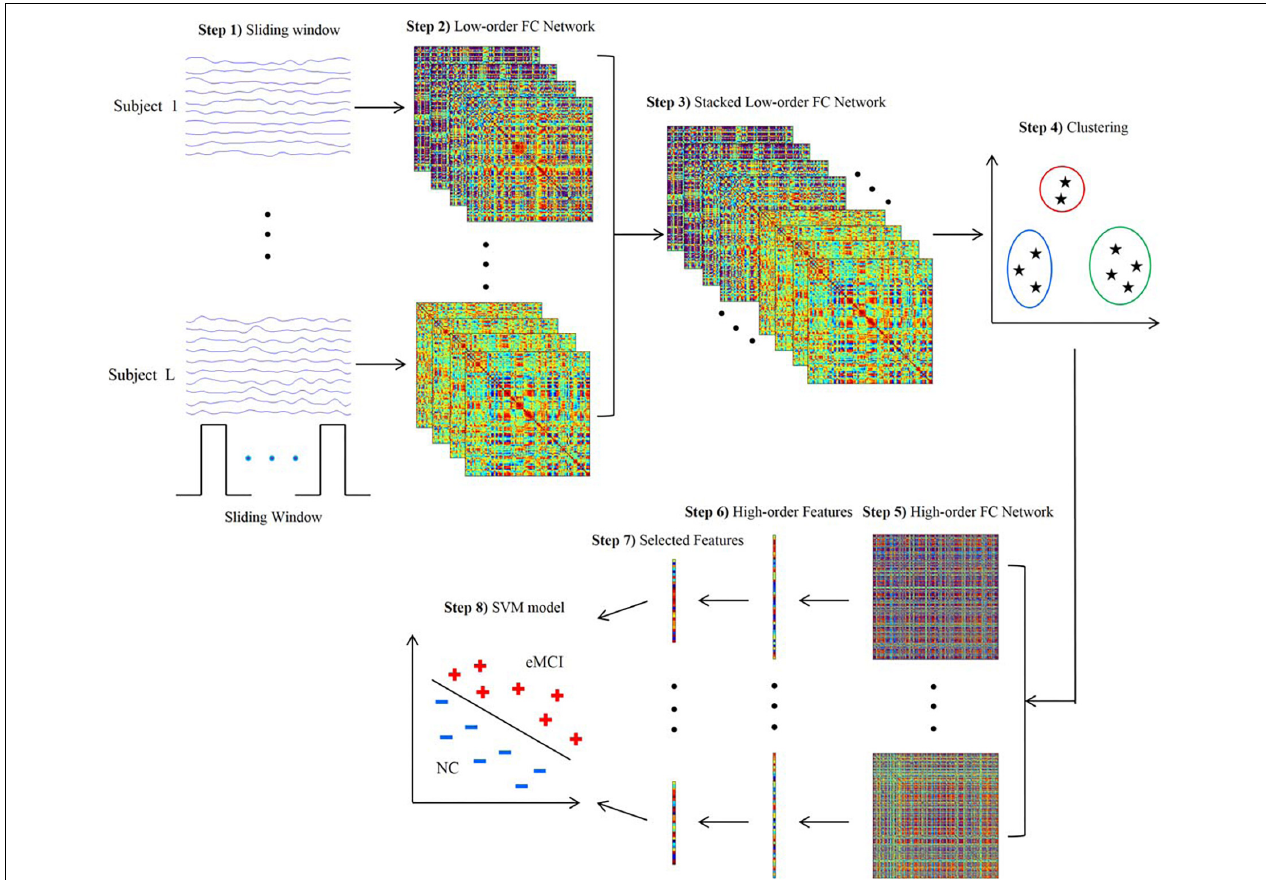
FIGURE 1 | Framework for construction of high-order functional connectivity (FC) network. (1) Partition of the RS-fMRI time series into multiple overlapping segments of subseries applying sliding-window technique; (2) collection of low-order FC matrices, one for each subseries; (3) stack of all matrices of all subjects together to obtain correlation time series for each element; (4) application of the clustering algorithm to group all the correlation time series; (5) construction of high-order FC network, considering the mean correlation time series for each cluster as vertex and the pairwise Pearson’s correlation coefficient between each pair of vertices as weight; (6) calculation of local clustering coefficients; (7) selection of a discriminative feature subset from the local clustering coefficients; (8) implementation of support vector machine (SVM) model for classification. RS-fMRI, resting-state functional magnetic resonance imaging; FC, functional connectivity (reproduced with permission from Chen et al.,